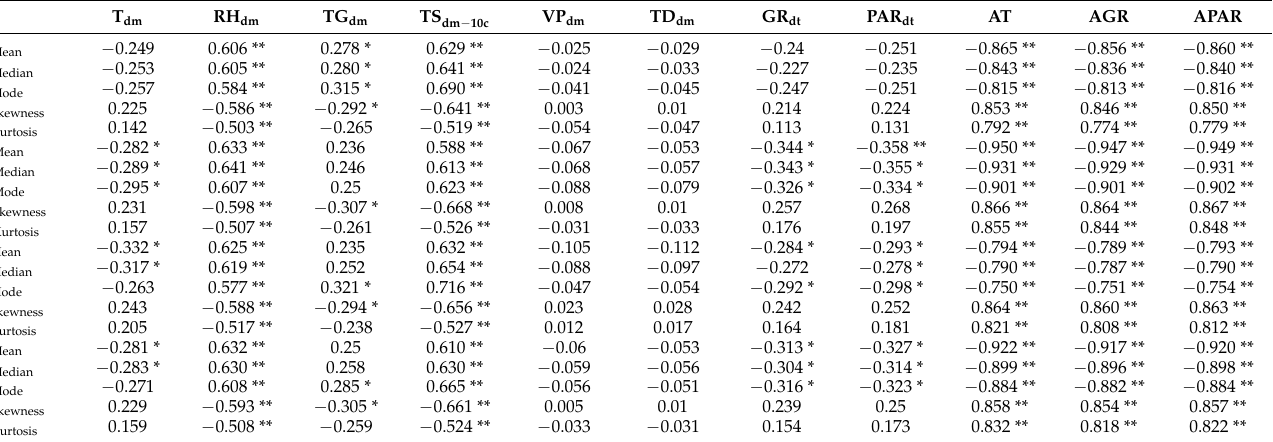
Table 2. Spearman correlation coefficient of population canopy CGSD parameters of BFH and microclimate